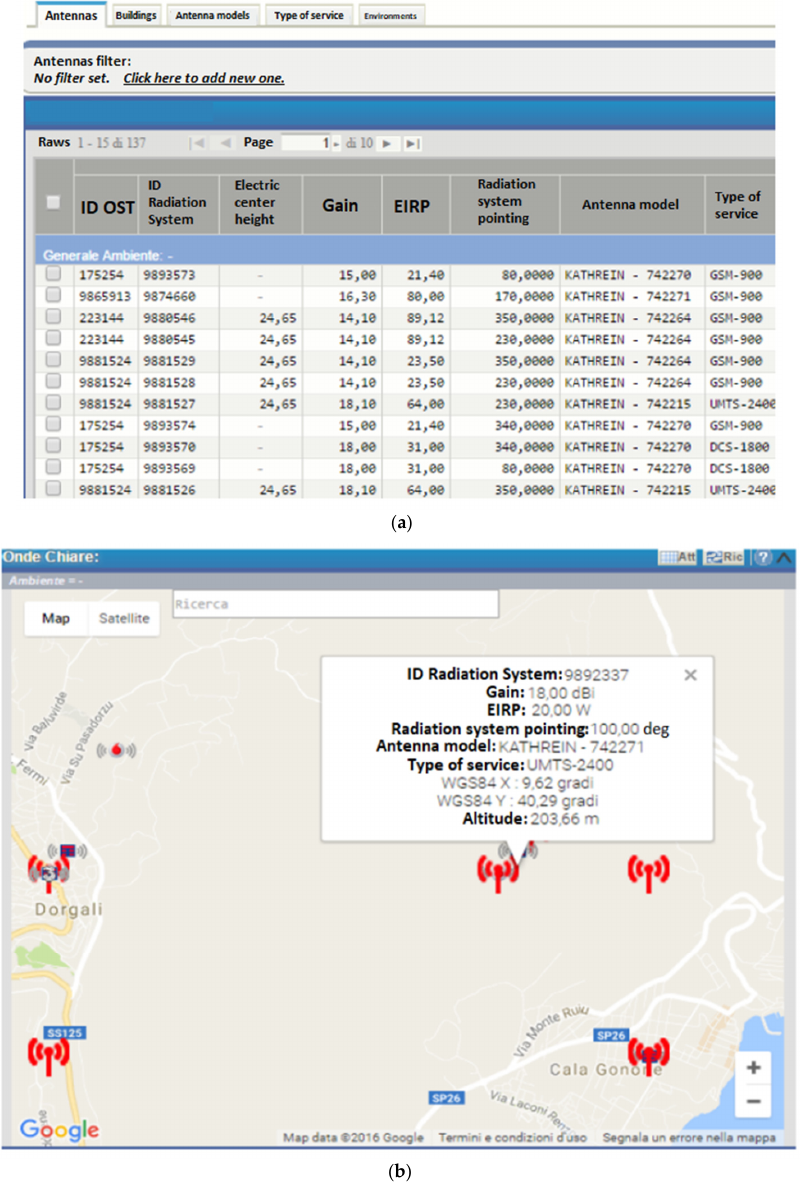
Figure 4. Examples of the web app of the Onde Chiare system. ( a ) The register of antennas contains information related to the position, the identification number, the height, the gain, the nominal power, the pointing direction, the antenna type, and the working frequency band. ( b ) The web app provides the actual location of the RBS in the region of interest, with the full set of information.